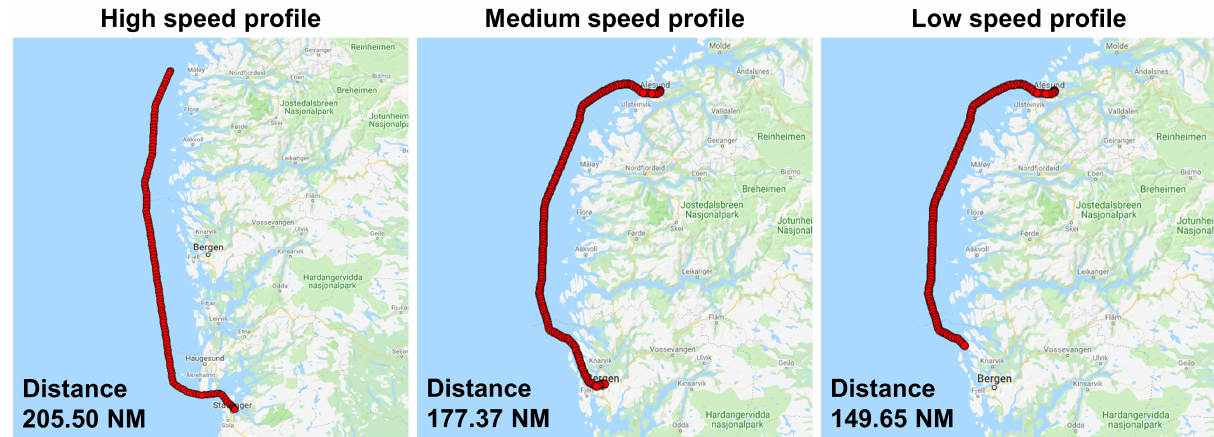
Figure 5. Itineraries of the scenario profiles in the Norwegian Sea.